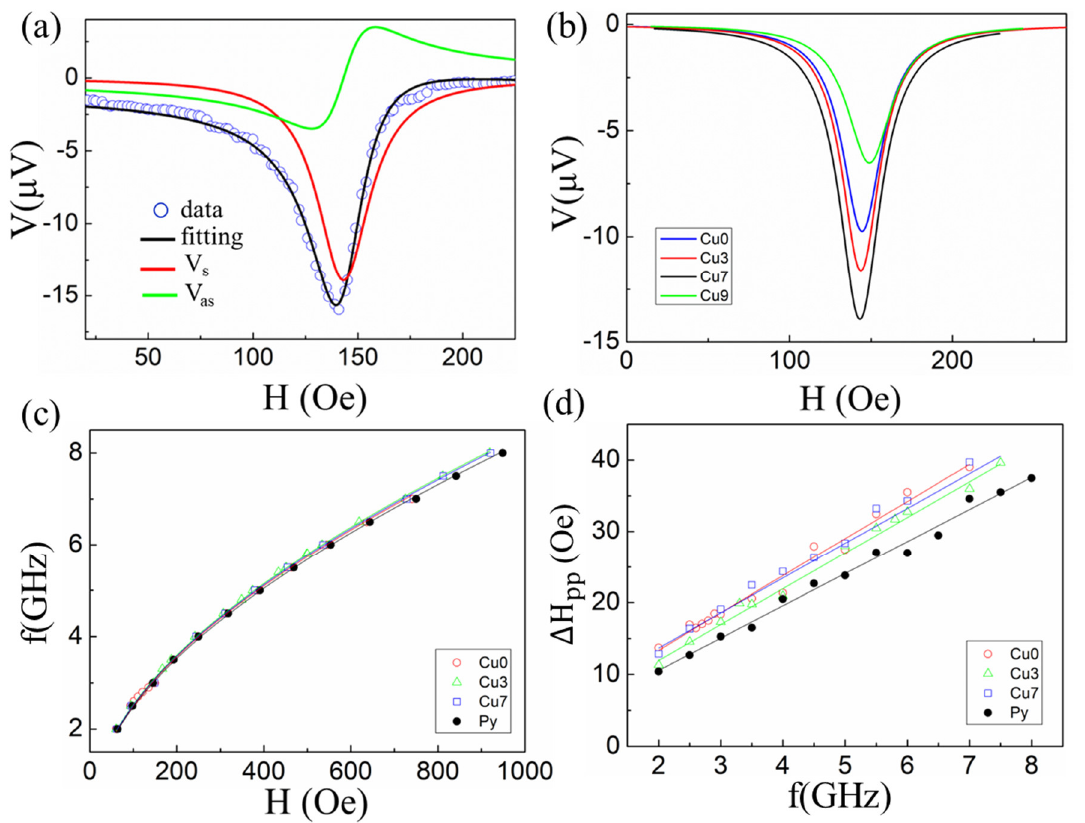
Figure 2. ( a ) DC voltage measured at 3GHz for Py/Cu (7nm)/Bi 2 Se 3 ; ( b ) V s extracted for various samples (Cu0, Cu3 and Cu7 denote t Cu = 0, 3, 7 nm respectively); ( c ) excitation frequency as a function of the resonant field. The solid lines are the curves fitted using Kittel formula; ( d ) frequency dependence of FMR linewidths for samples with different Cu thicknesses. The solid lines show the linear fit from which the damping factor (α) of each sample is derived.